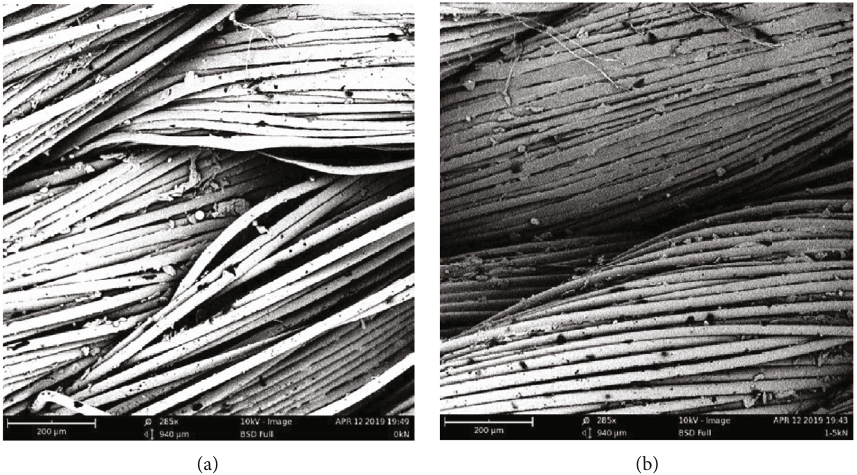
Figure 11: Scanning electron microscope images: (a) virgin specimen, (b) specimen after a 1-5kN